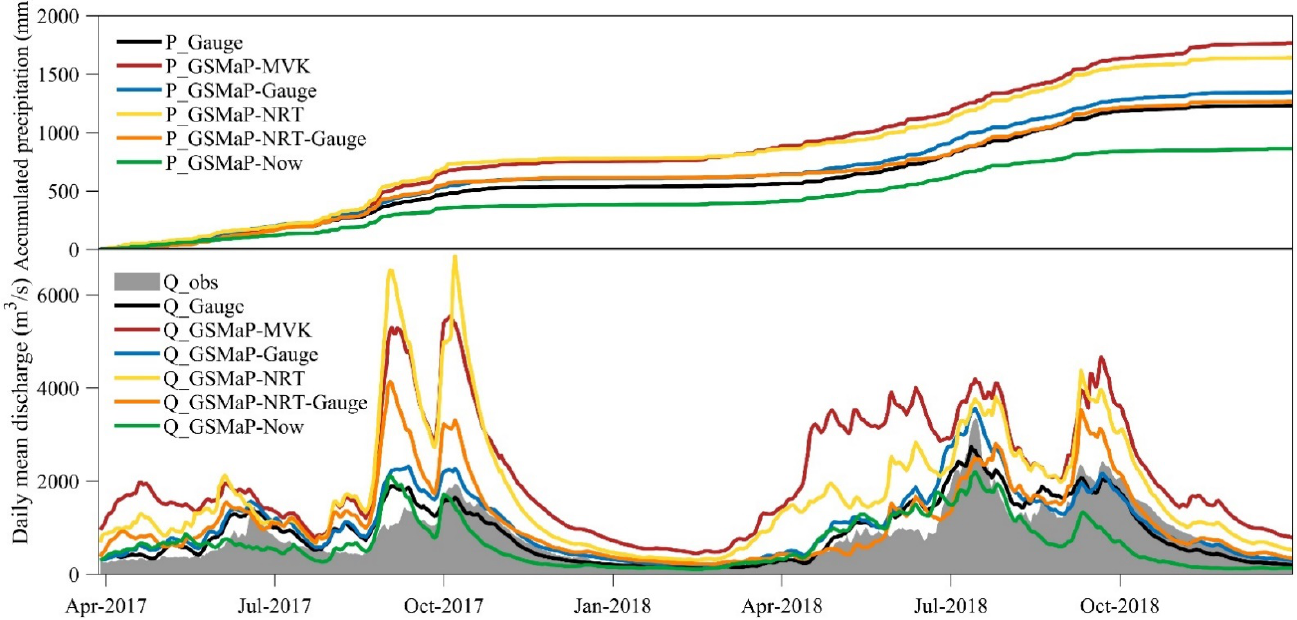
Figure 9. Observed and simulated daily hydrographs at the Tangnaihai hydrological station using the rain-gauge-, GSMaP-MVK-, GSMaP-Gauge-, GSMaP-NRT-, GSMaP-NRT-Gauge-, and GSMaP-Now-based precipitation data inputs in the period of March 29, 2017–December 31, 2018 (Q_obs denotes the observed discharge; Q_Gauge represents the simulated discharge using the rain-gauge-based precipitation data; Q_GSMaP-MVK, Q_GSMaP-Gauge, Q_GSMaP-NRT, Q_GSMaP-NRT-Gauge, and Q_GSMaP-Now are the simulated streamflow using GSMaP-MVK, GSMaP-Gauge, GSMaP-NRT, GSMaP-NRT-Gauge, and GSMaP-Now SPPs, respectively; P_Gauge denotes the rain-gauge-based basin-averaged precipitation; and P_GSMaP-MVK, P_GSMaP-Gauge, P_GSMaP-NRT, P_GSMaP-NRT-Gauge, and P_GSMaP-Now represent the GSMaP-MVK-, GSMaP-Gauge-, GSMaP-NRT-, GSMaP-NRT-Gauge-, and GSMaP-Now-based basin-averaged precipitation, respectively).